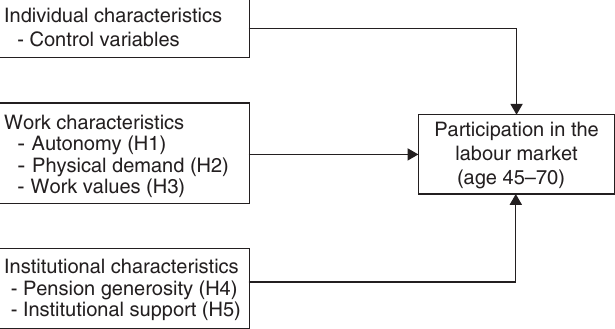
Figure 1. Indi v idual, work and institutional factors relating to older workers’ labor market